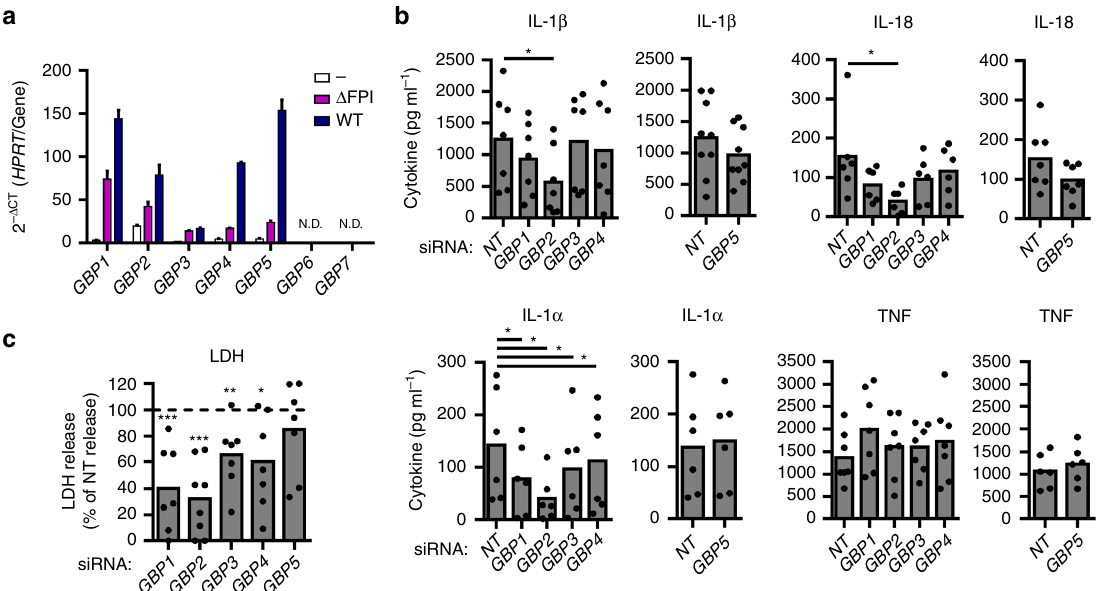
Fig. 7 Multiple GBPs promote non-canonical in fl ammasome activation in hMDMs infected with F . novicida . a Expression pro fi le of GBPs by qRT-PCR in hMDMs infected with wild-type F . novicida or the Δ FPI mutant at a multiplicity of infection (MOI) of 10 for 8 h. b , c hMDMs were transfected with non- targeting siRNA (NT) or with the indicated siRNA and infected with F . novicida at a MOI of 10 for 6 h (IL-1 β , TNF, LDH) or 8 h (IL-18 and IL-1 α ). b IL-1 β , IL-18, IL-1 α , and TNF levels in the supernatant were quanti fi ed by ELISA. c Cell death was assessed by measuring LDH release. a Mean values ± standard deviation from three independent experiments are shown. b , c Each point shows the mean value from three technical replicates for one healthy donor. The bar shows the mean for all donors ( n ≥ 6). c For each healthy donor, the mean value from cells transfected with NT siRNA was used as a reference value set to 100%. Two-tailed p values with the following nomenclature (*** p < 0.001, ** p < 0.01, and * p < 0.05 by paired t -test) are